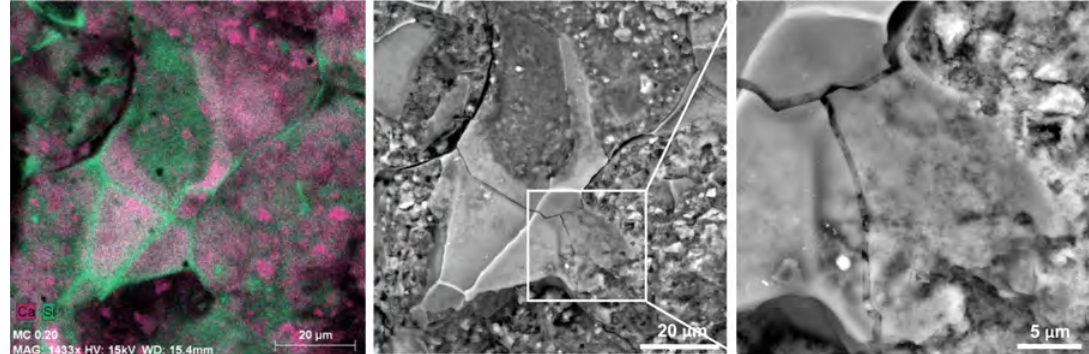
Figure 3. SEM – EDS of integrated perlite fines – Si content decrease and detail of lamella integration. The decreasing tendency of Si content can be also presented on EPMA with EDX analysis results of perlite lamella and cement matrix boundary. Figure show positions of testing and Table describes weight percentage containment (wpc) of individual elements in each position of interest. Position 4 with Si con- tainment 10 . 55% of weight correspond to CSH phases and Position 8 (Si wpc 16 . 31%) to pure perlite [9].